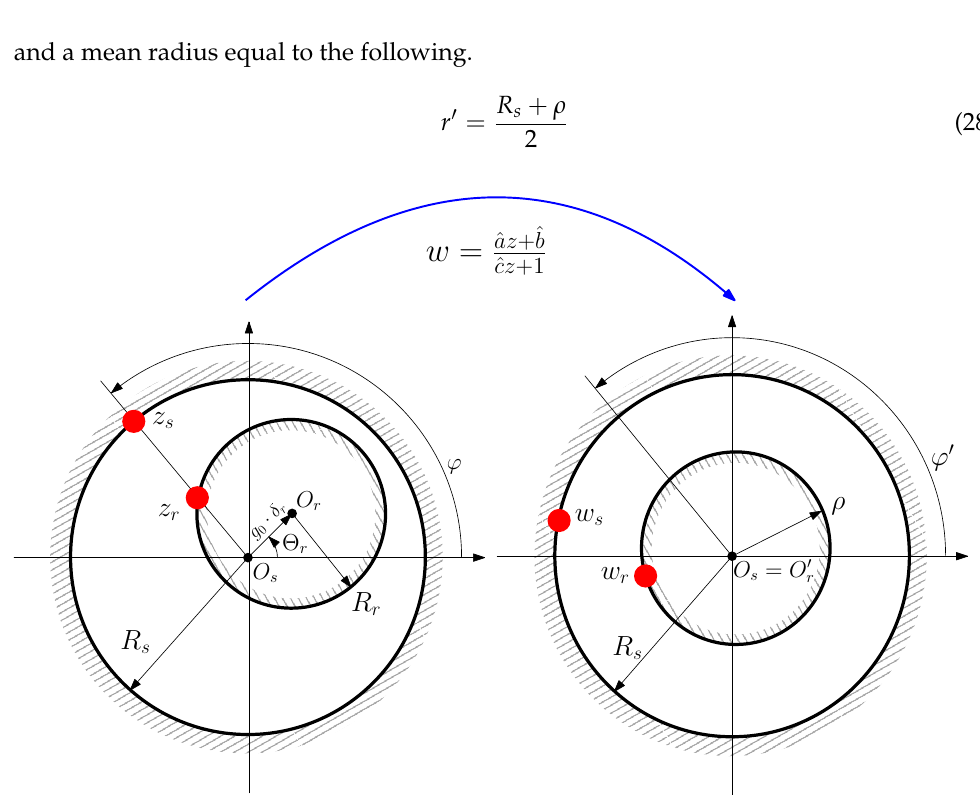
Figure 11. The Moebius transformation of an eccentric IM with non-uniform air gap ( left ) gives a non-eccentric IM with a uniform air gap ( right ), but with modified conductor angular positions and with a different rotor